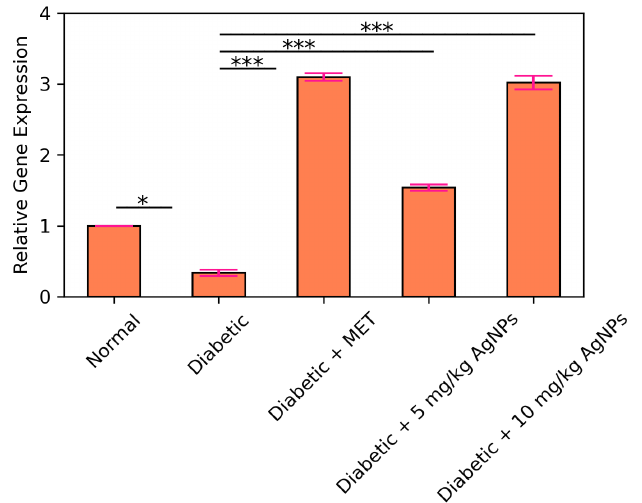
Figure 18. Relative expression of AMPK in control, diabetic untreated, and diabetic metformin- and AgNPs-treated (28 days) groups. Significance was determined by One Way ANOVA following Bonferroni’s Multiple comparison Post Hoc Test. Error bars represent the SEM (standard error of the mean) (* p < 0.05, *** p <